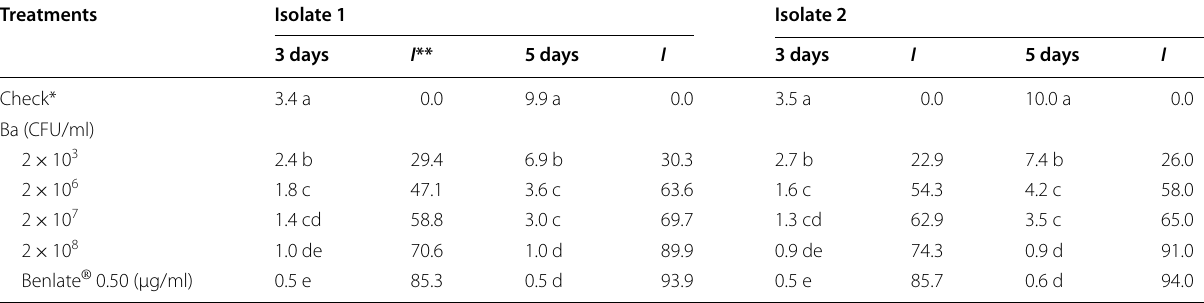
100. Data are averages of 10 replicates. ×